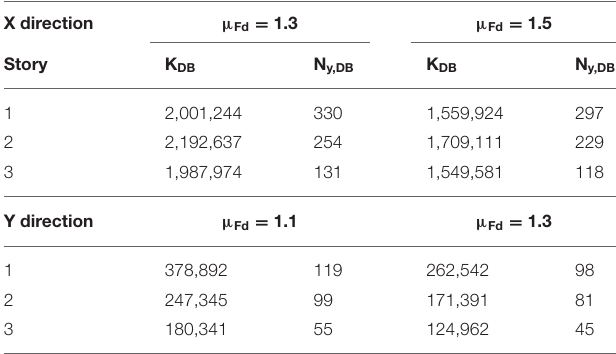
TABLE 3C | Stiffness (kN/m) and strength (kN) of the HYDBs (case B, LS limit state). X direction µ Fd =